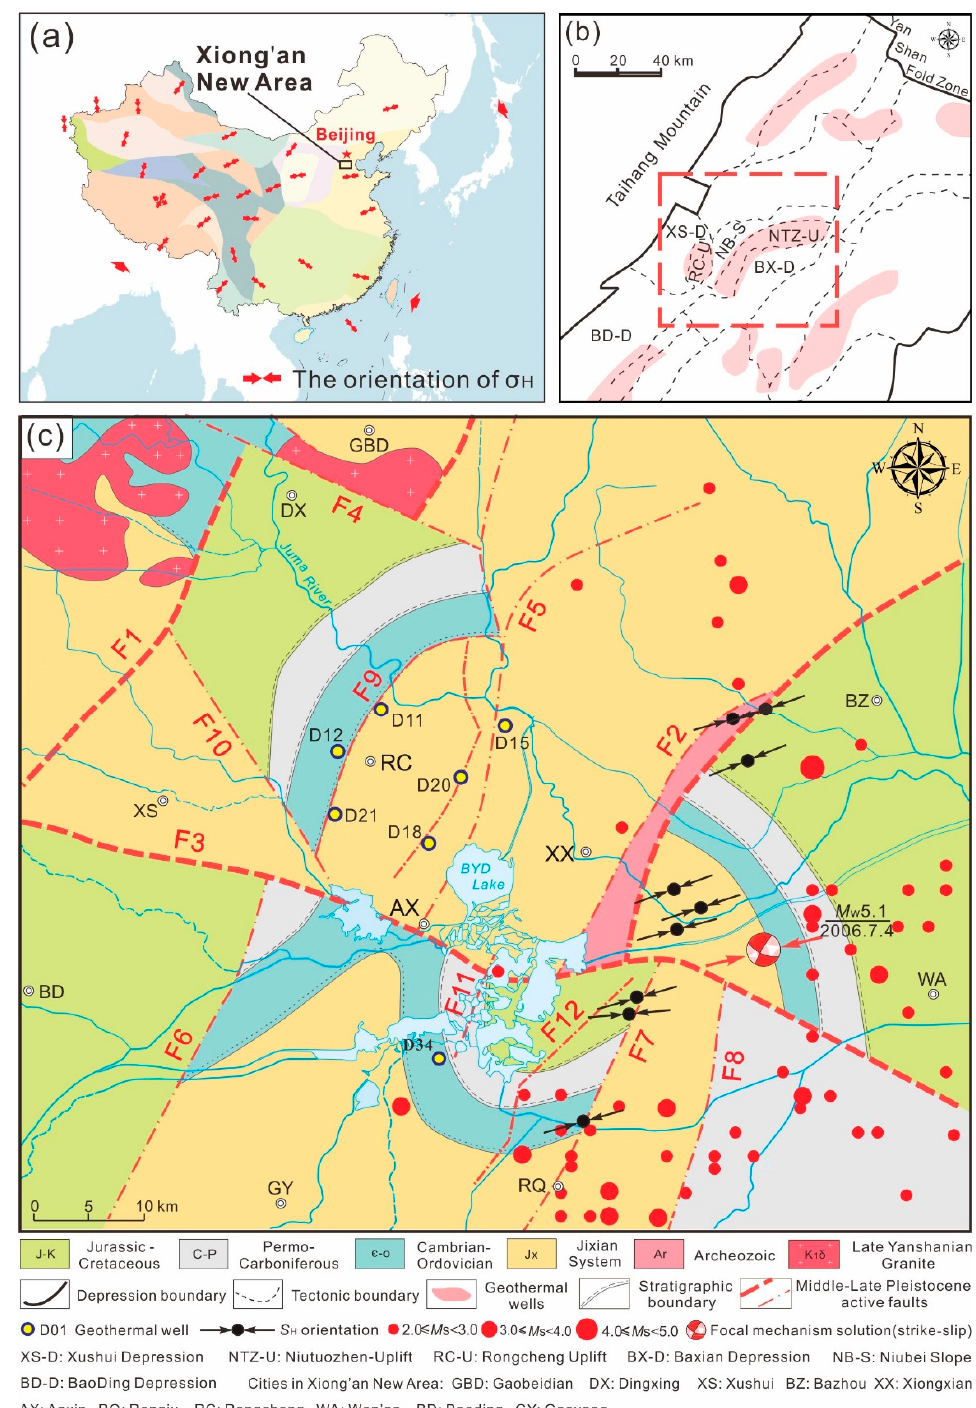
Figure 1. Geological structures of bed rock and the Middle-Late Pleistocene active faults distributed in and around Xiong’an New Area. ( a ) The location of Xiong’an New Area in China and regional division of the recent tectonic stress field in China (modified from [26]). ( b ) The geothermal fields distributed in the Jizhong Depression (modified from [22]). ( c ) The Middle-Late Pleistocene active faults, historical earthquakes (since 1970), and existing geothermal exploration boreholes in the Xiong’an New Area (modified from [21–24]). F1: Baoding-Shijiazhuang Fault, F2: Niudong Fault, F3: Xushui-Dacheng Fault, F4: Dingxing Fault, F5: Eastern Boundary Fault of the Rongcheng uplift, F6: Gaoyang-Boye Fault, F7: Renqiu Fault, F8: Maxi Fault, F9: Western Boundary Fault of the Rongcheng uplift, F10: an unnamed Secondary Fault, F11: Chu’an Fault, F12: Renxi Fault.